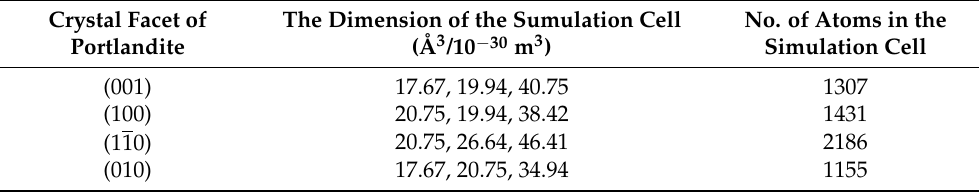
Table A1. Crystallographic data of Portlandite consisting of different crystal facets at 298